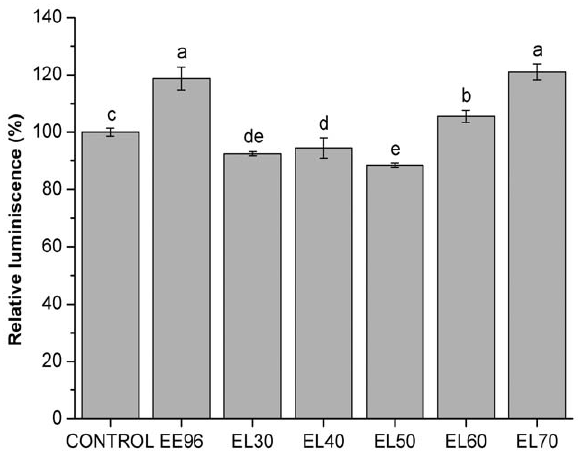
Figure 4. Intracellular oxidation in the yeast S. cerevisiae treated with EL30 to EL70 eluates. Data are means (n=3) and are expressed as fluorescence relative to control. Values followed by the same letter (a–e) are not statistically different (P , 0.05), as measured by Duncan’s test.